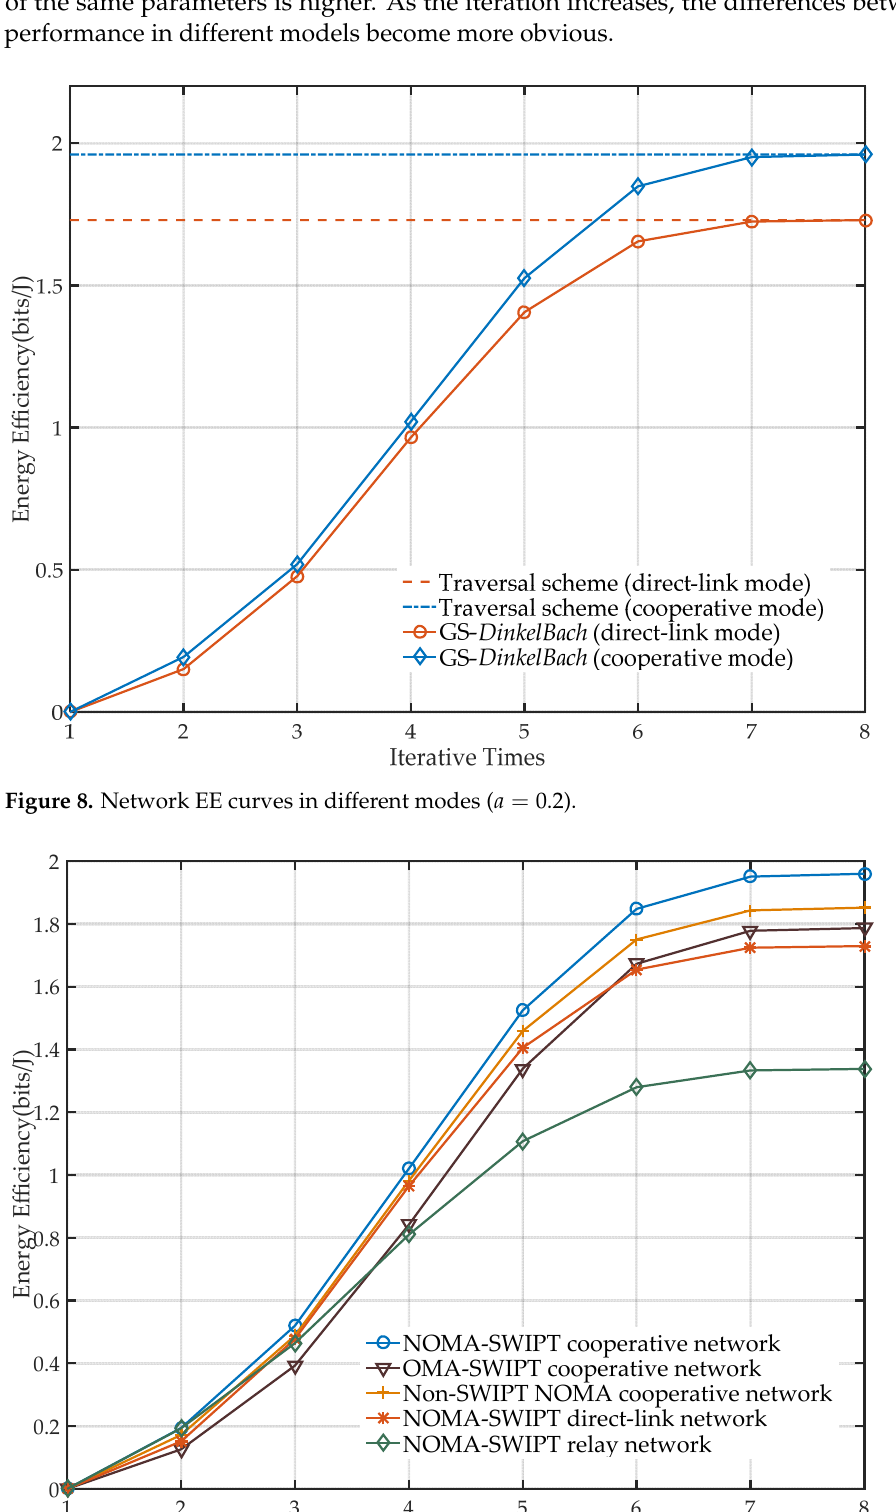
Figure 9. Comparison of EE performance in different system models ( 𝑎 = 0.2 ).